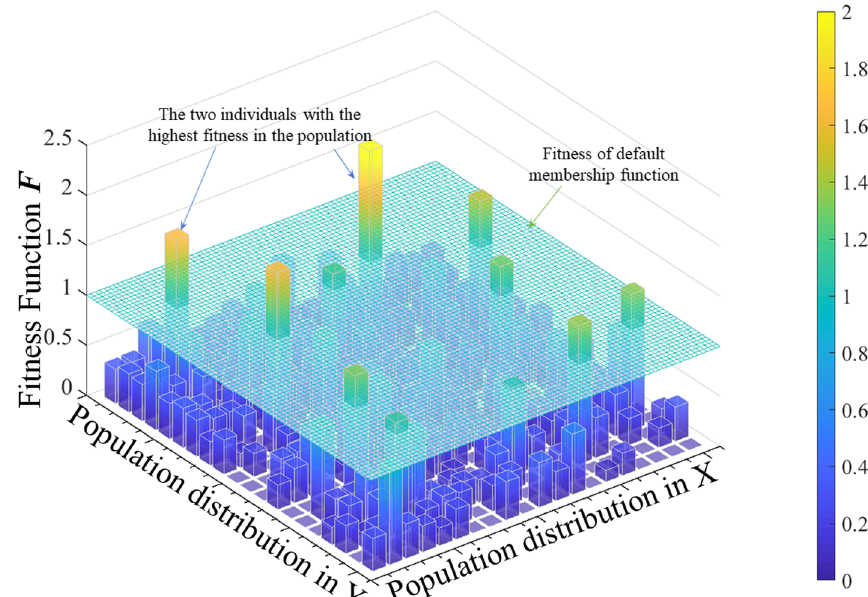
Fig. 3 Fitness function F of a generation of population for fuzzy decision-making